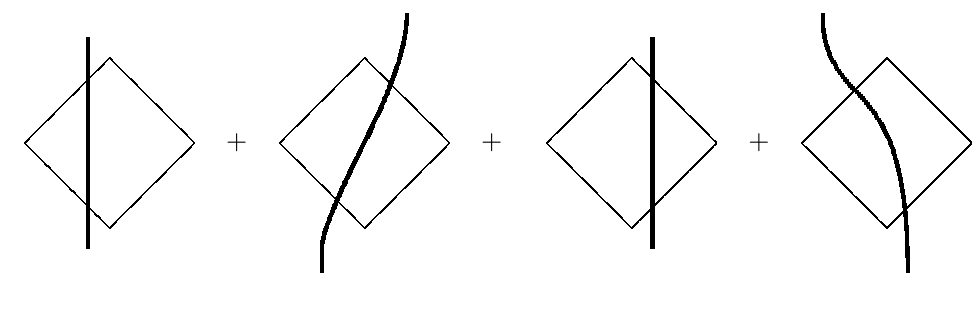
Figure 16 . Complete contribution to A (cid:0) A (cid:3) .